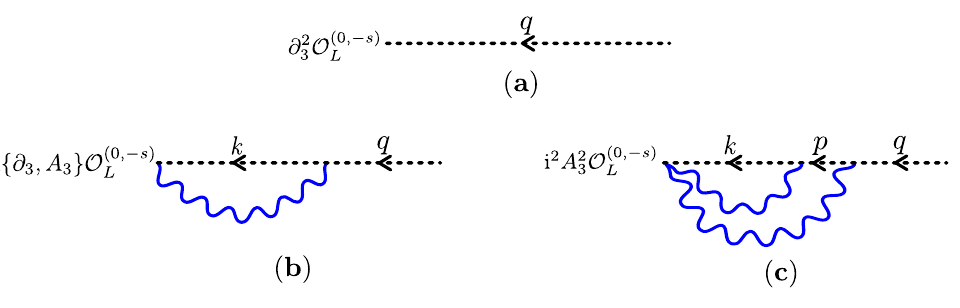
Figure 11 . The three diagrams that contributes to the vertex V computation of h δ 2